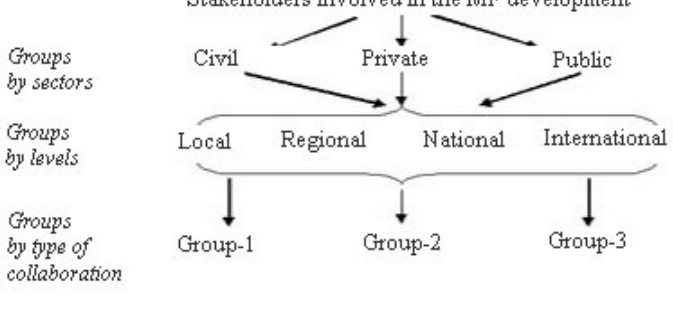
Fig. 1. Description of our approach to divide stakeholders into different: (1) sectors, (2) levels of organization, and (3) levels of collaboration to analyze the structure of multi-stakeholder collaboration in MF initiatives in the Russian Federation and